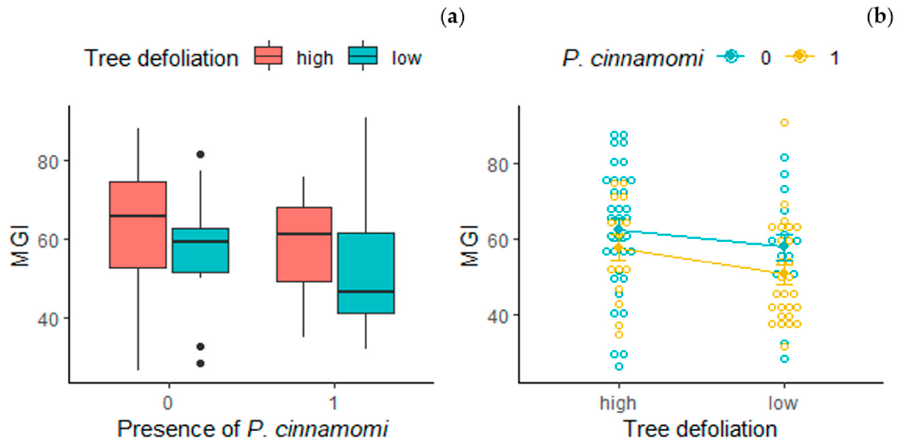
Figure 3. Interaction analysis between presence of P. cinnamomi and tree defoliation over MGI: ( a ) ( a ) boxplot of MGI depending on tree defoliation and presence of P. cinnamomi ; ( b ) interaction graph for presence of P. cinnamomi and tree defoliation (adjusted means models graph) including violin scatter with data of the MGI of the 95 Trichoderma spp. strains